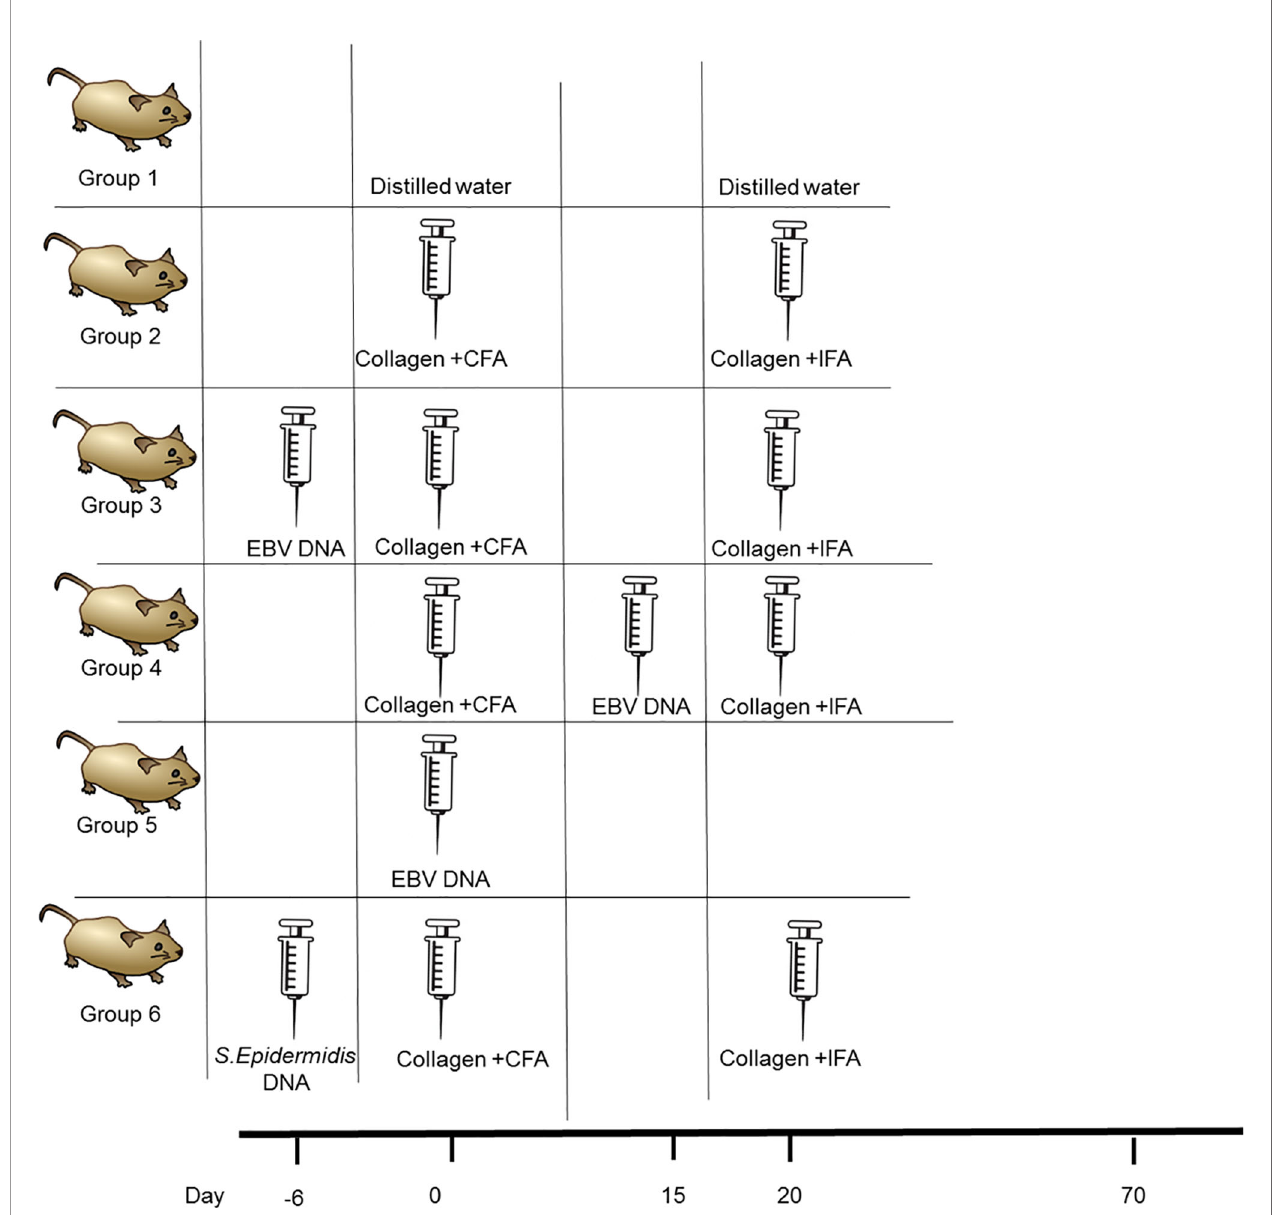
FIGURE 1 | Treatment regimen for assessing the effect of EBV DNA in the type II chicken collagen-induced arthritis C57BL/6J mouse model. EBV, Epstein-Barr virus; CFA, complete Freund ’ s adjuvant; IFA, incomplete Freund ’ s